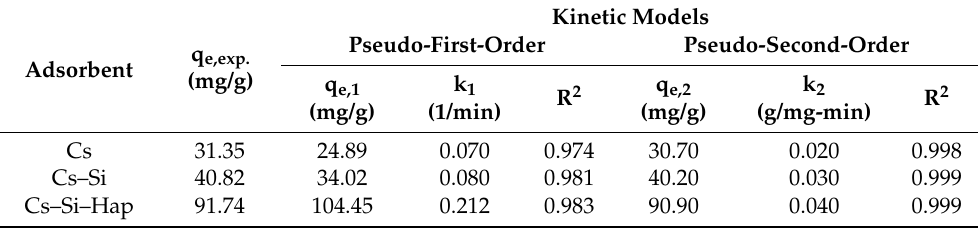
Table 1. Kinetic models parameters for Cr(VI) adsorption.